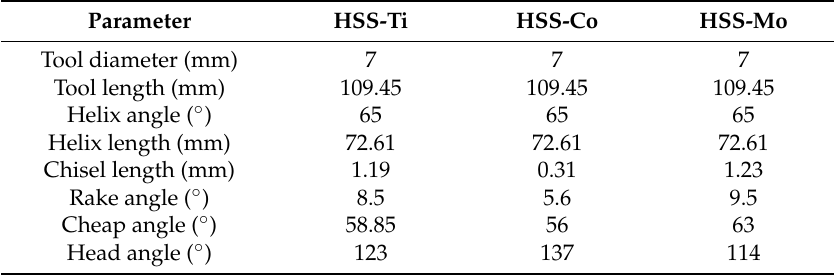
Table 3. Machining parameters. Table 2. Geometric parameters for drill